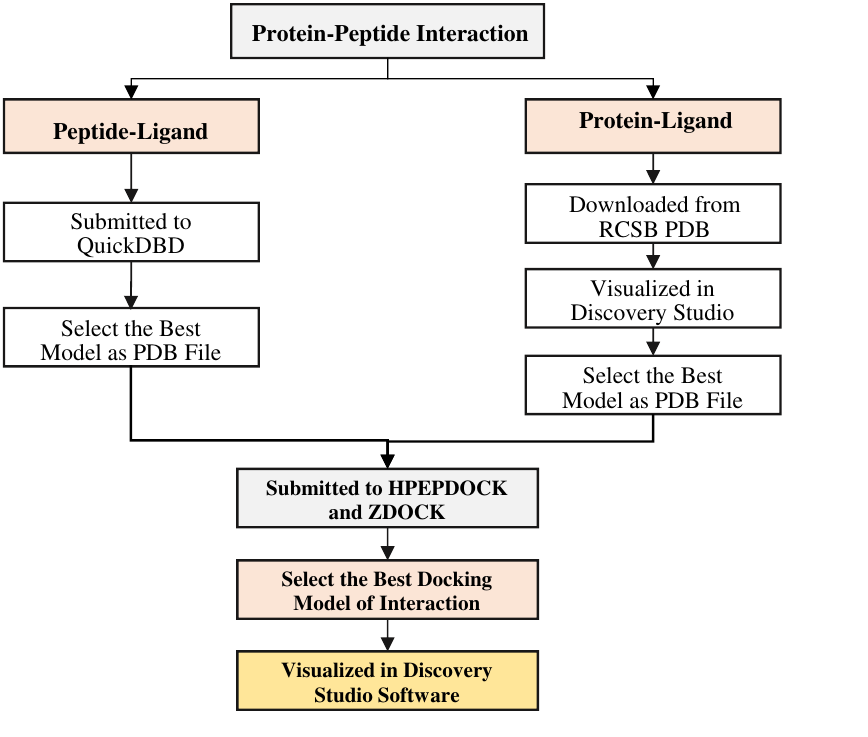
Figure 2. Workflow for protein-peptide docking